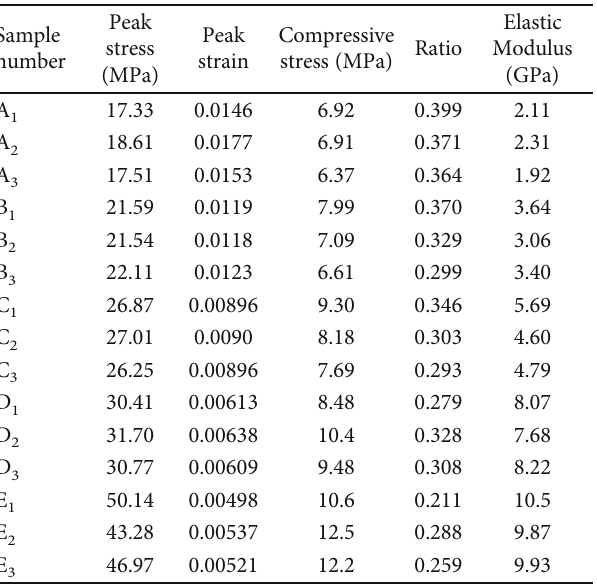
Figure 4: The curve of volumetric strain and crack volumetric strain of rock. Table 3: Rock mechanical parameters.